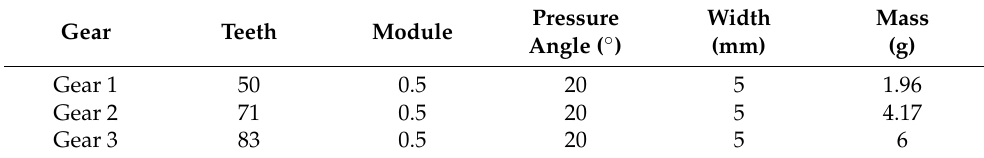
Table 1. The parameters of the gears.